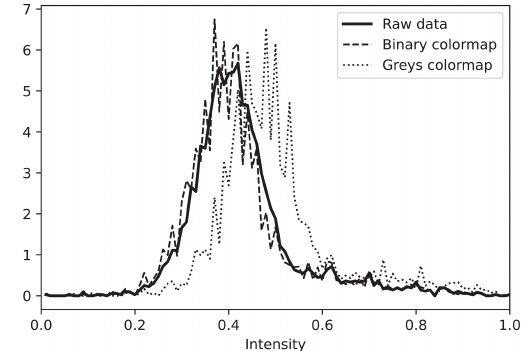
Figure A1. Comparison of the intensity distribution in the origi- nal (raw) data and image plotted using Python Matplotlib with dif- ferent grayscale color